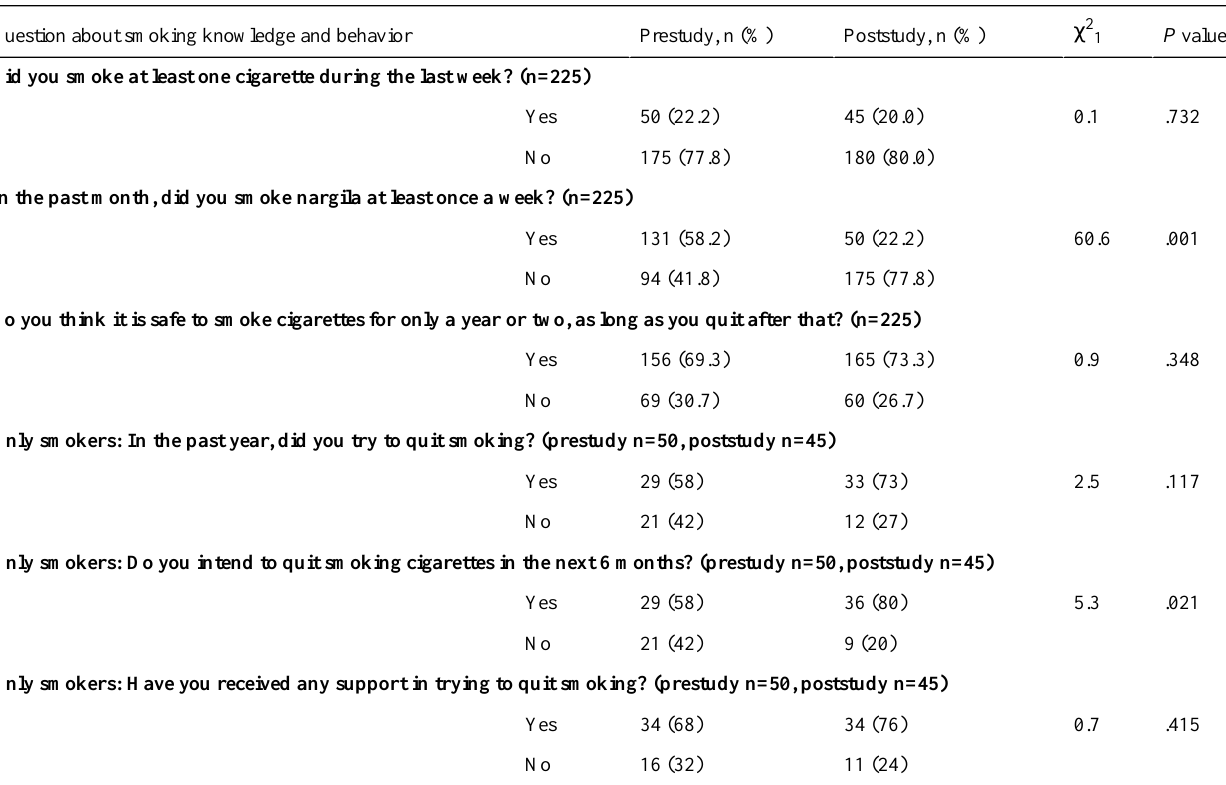
Table 2. Pre-/poststudy smoking knowledge and behavior of participants.